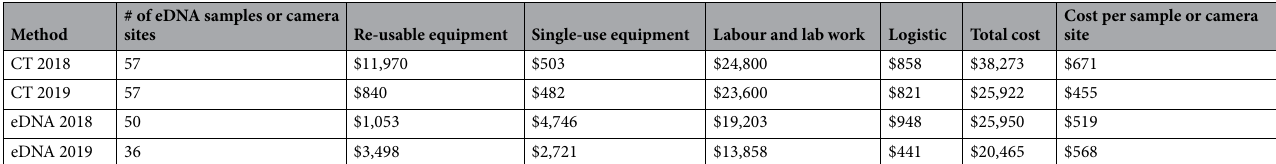
Table 1. Costs of terrestrial mammal inventory for each survey method and year (US $). The table shows a summary of the costs for each survey method and year. Total cost calculation includes four budget components: re-usable equipment , single use equipment , labour and lab work , and logistic . Re-usable equipment includes camera traps, water pumps and rechargeable batteries, single use equipment includes AA batteries and eDNA sampling kits, labour and lab work combines staff time for field work as well as time spent for data analysis, logistic includes expenses related to local transportation from headquarters to field study sites. Cost per eDNA sample or camera trap site is obtained by dividing the total cost by the number of samples or sites. See Supplementary Table 4 for detailed description of each cost component.